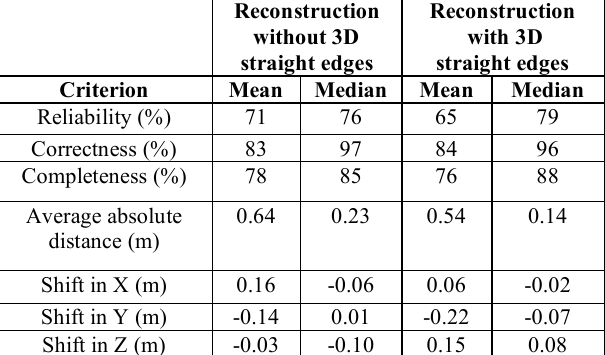
Table 3. Accuracy assessment of the reconstructed